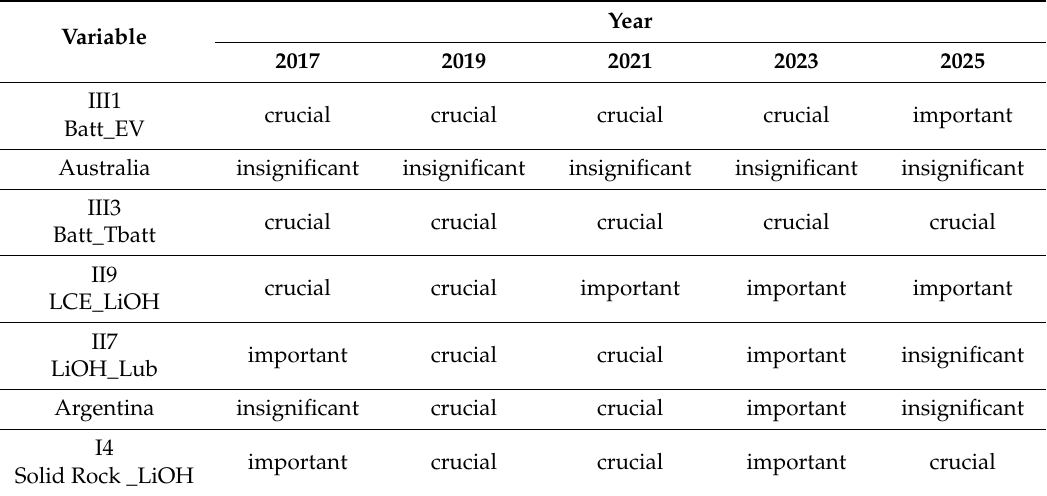
Table 6. Variable classification with Monte Carlo